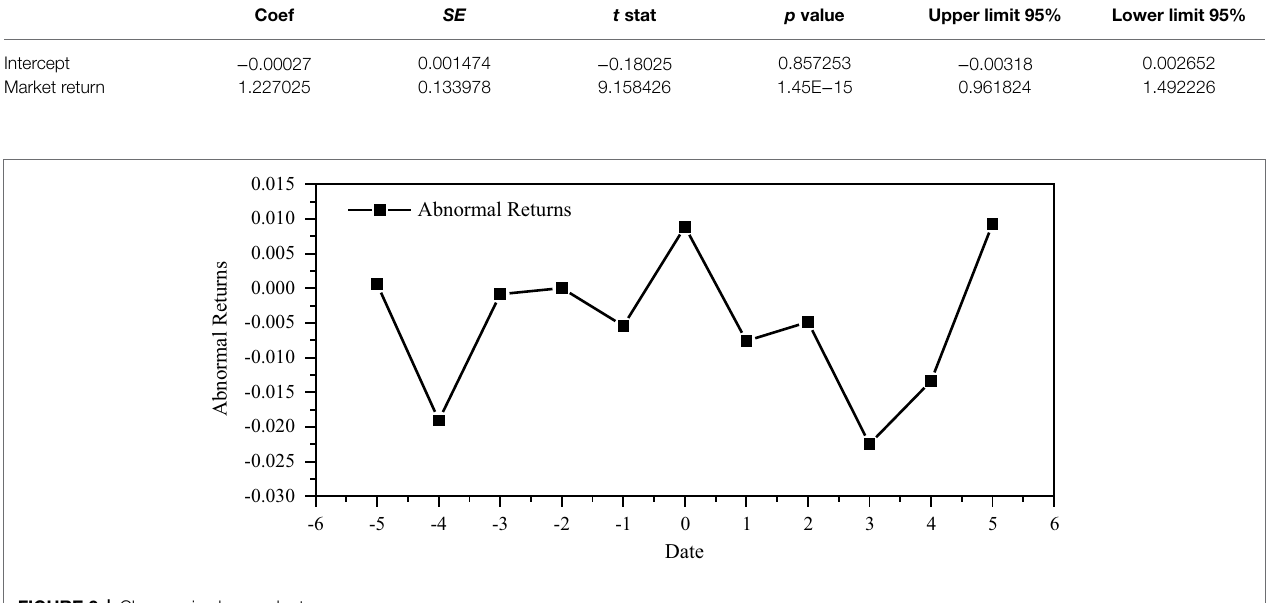
FIGURE 2 | Changes in abnormal returns.